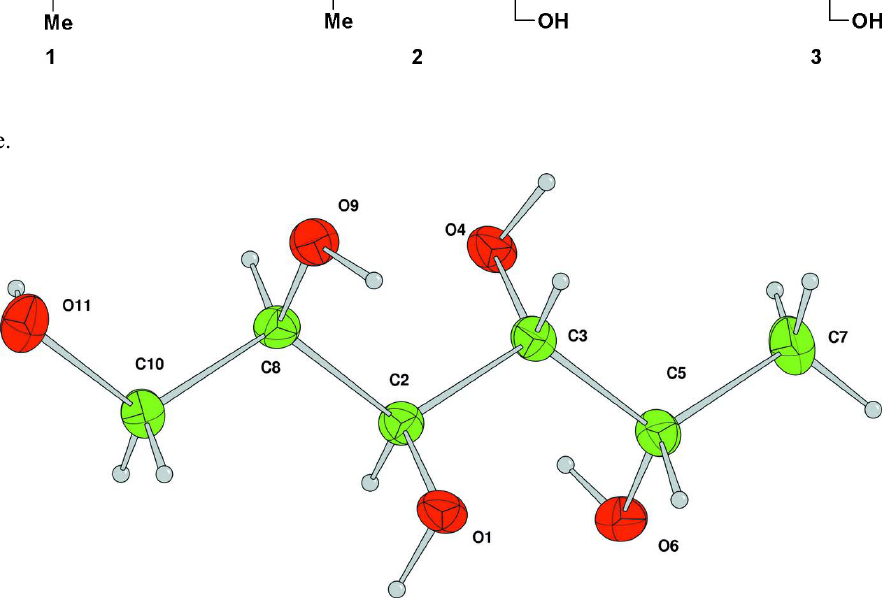
Figure 2 The title compound with displacement ellipsoids drawn at the 50% probability level. H atoms are shown as spheres of arbitary